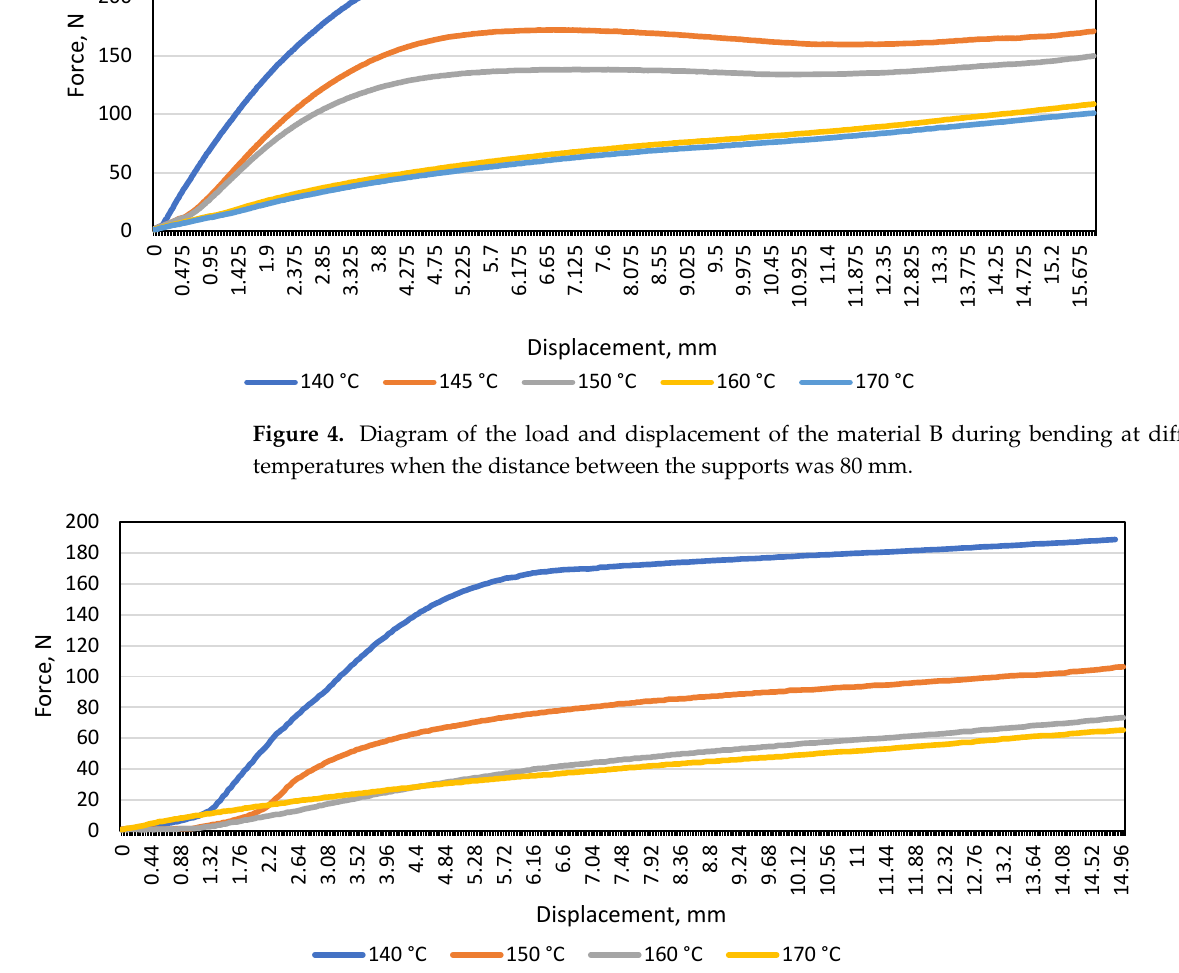
Figure 5. Diagram of load and displacement of monochrome material A under bending at different temperatures when the distance between the supports was 100 mm.